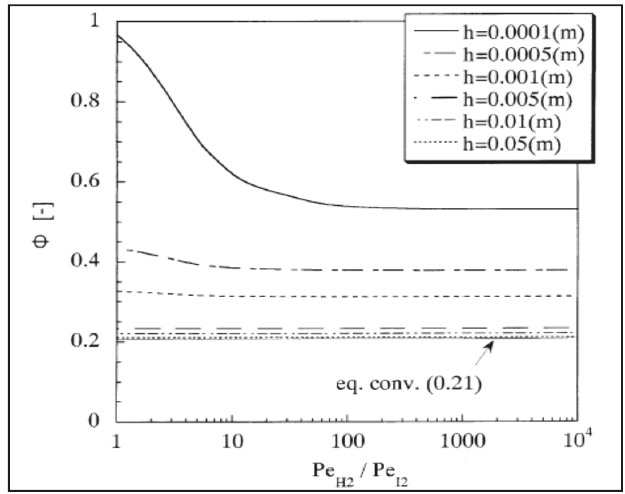
Figure 8. HI conversion versus H 2 /I 2 perm-selectivity for silica membrane at various h values. With permission of reprint from Elsevier by Hwang and Onuki [38].